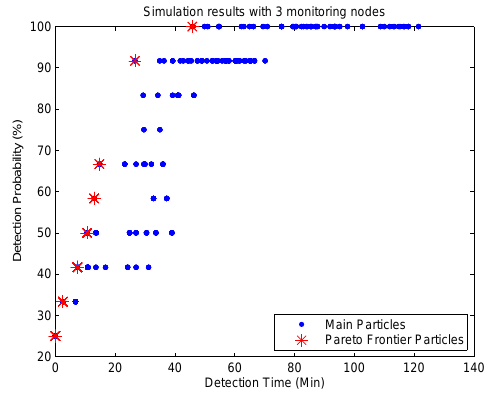
Figure 5. Enumeration search results.